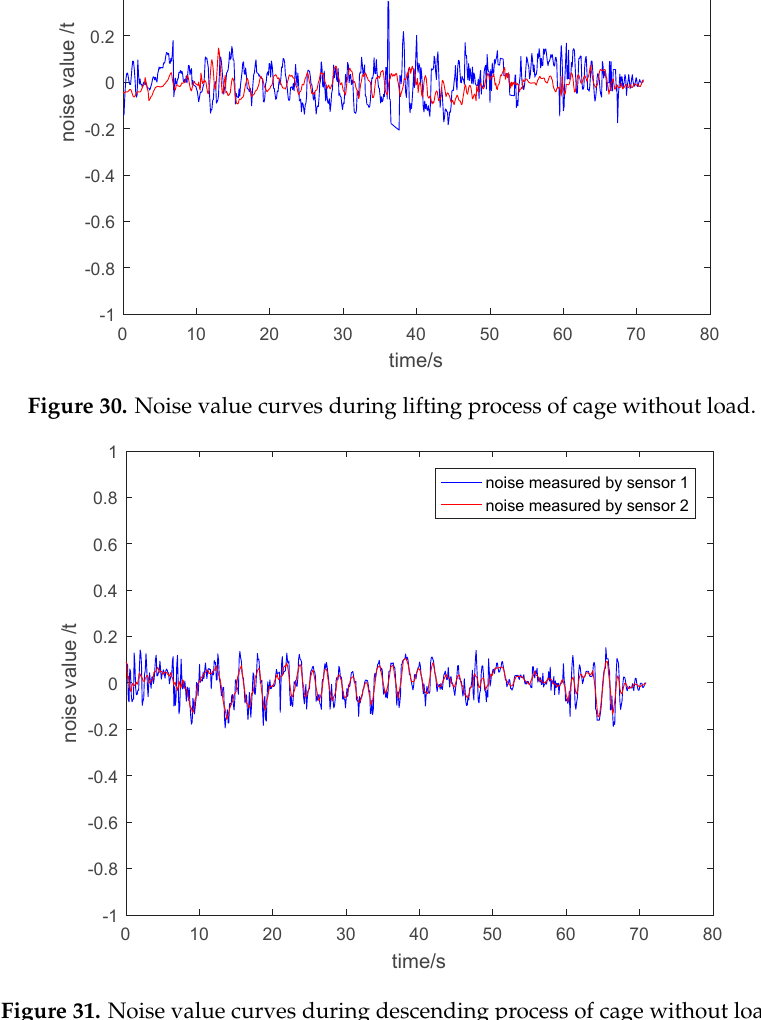
Figure 31. Noise value curves during descending process of cage without load.